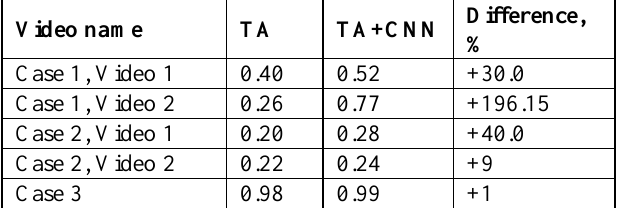
Table 1. Comparison tracking quality with and without